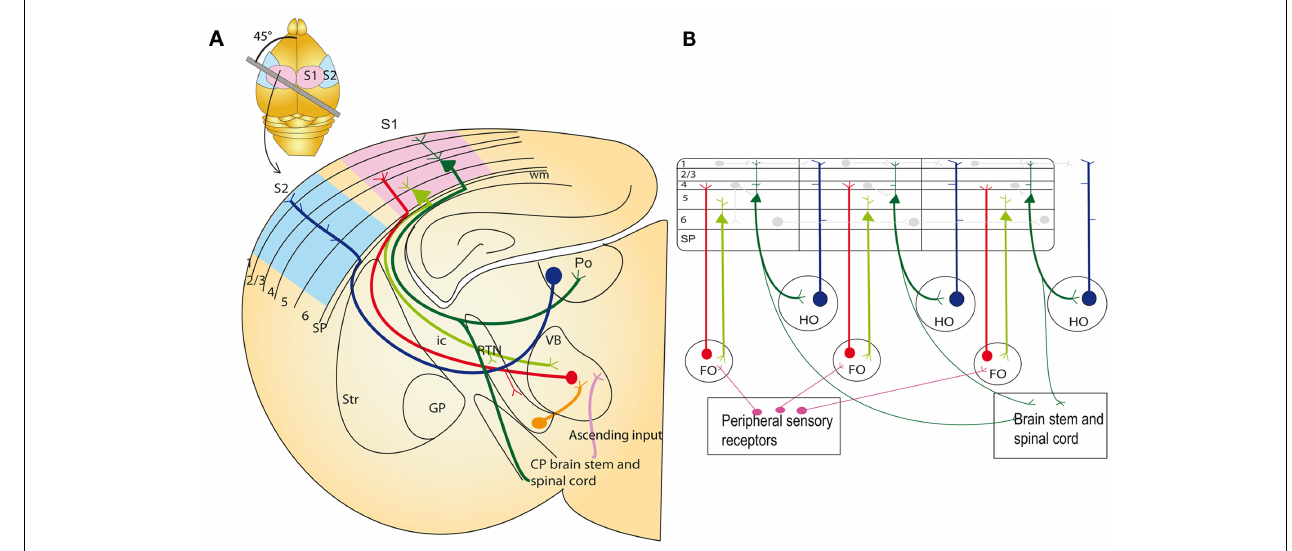
light pink).This projection pattern generates an open loop. (B) Schematic illustration of the possible functional circuits generated by this reoccurring open loop connectivity. Sensory information is relayed through the first order thalamic nucleus to the cortex (red).This cortical area then projects from layer 6 reciprocally back to the first order nucleus (light green). Each area is also non-reciprocally connected to a higher order thalamic nucleus.The layer 5 input to the thalamus (dark green) is an “efference copy” of the layer 5 output to the motor system in the brainstem and spinal cord.This copy is forwarded to a higher cortical area (blue). Direct cortico-cortical connections are also depicted between cortical layers and cortical areas (pale gray lines).These circuits enable cortical areas to act with other cortical areas and motor apparatus in a coordinated manner. Modified from Sherman and Guillery (2002). CP, cerebral peduncle; FO, first order thalamic nuclei; GP, globus pallidus; HO, higher order thalamic nuclei; ic, internal capsule; RTN, reticular thalamic nuclei; SP, subplate; Str, striatum; S1, primary somatosensory cortex; S2, secondary association somatosensory cortex; Po, posterior thalamic nuclei;VB, ventrobasal thalamic nuclei; wm, white